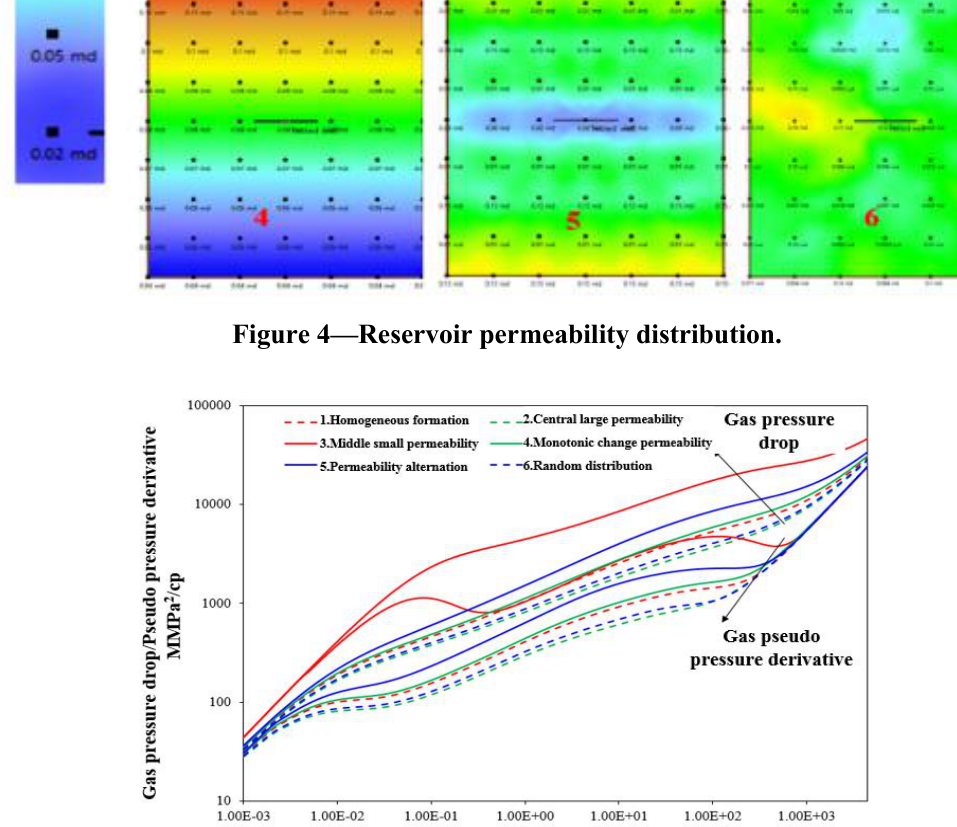
Figure 5—Influence of heterogeneity of permeability on well test